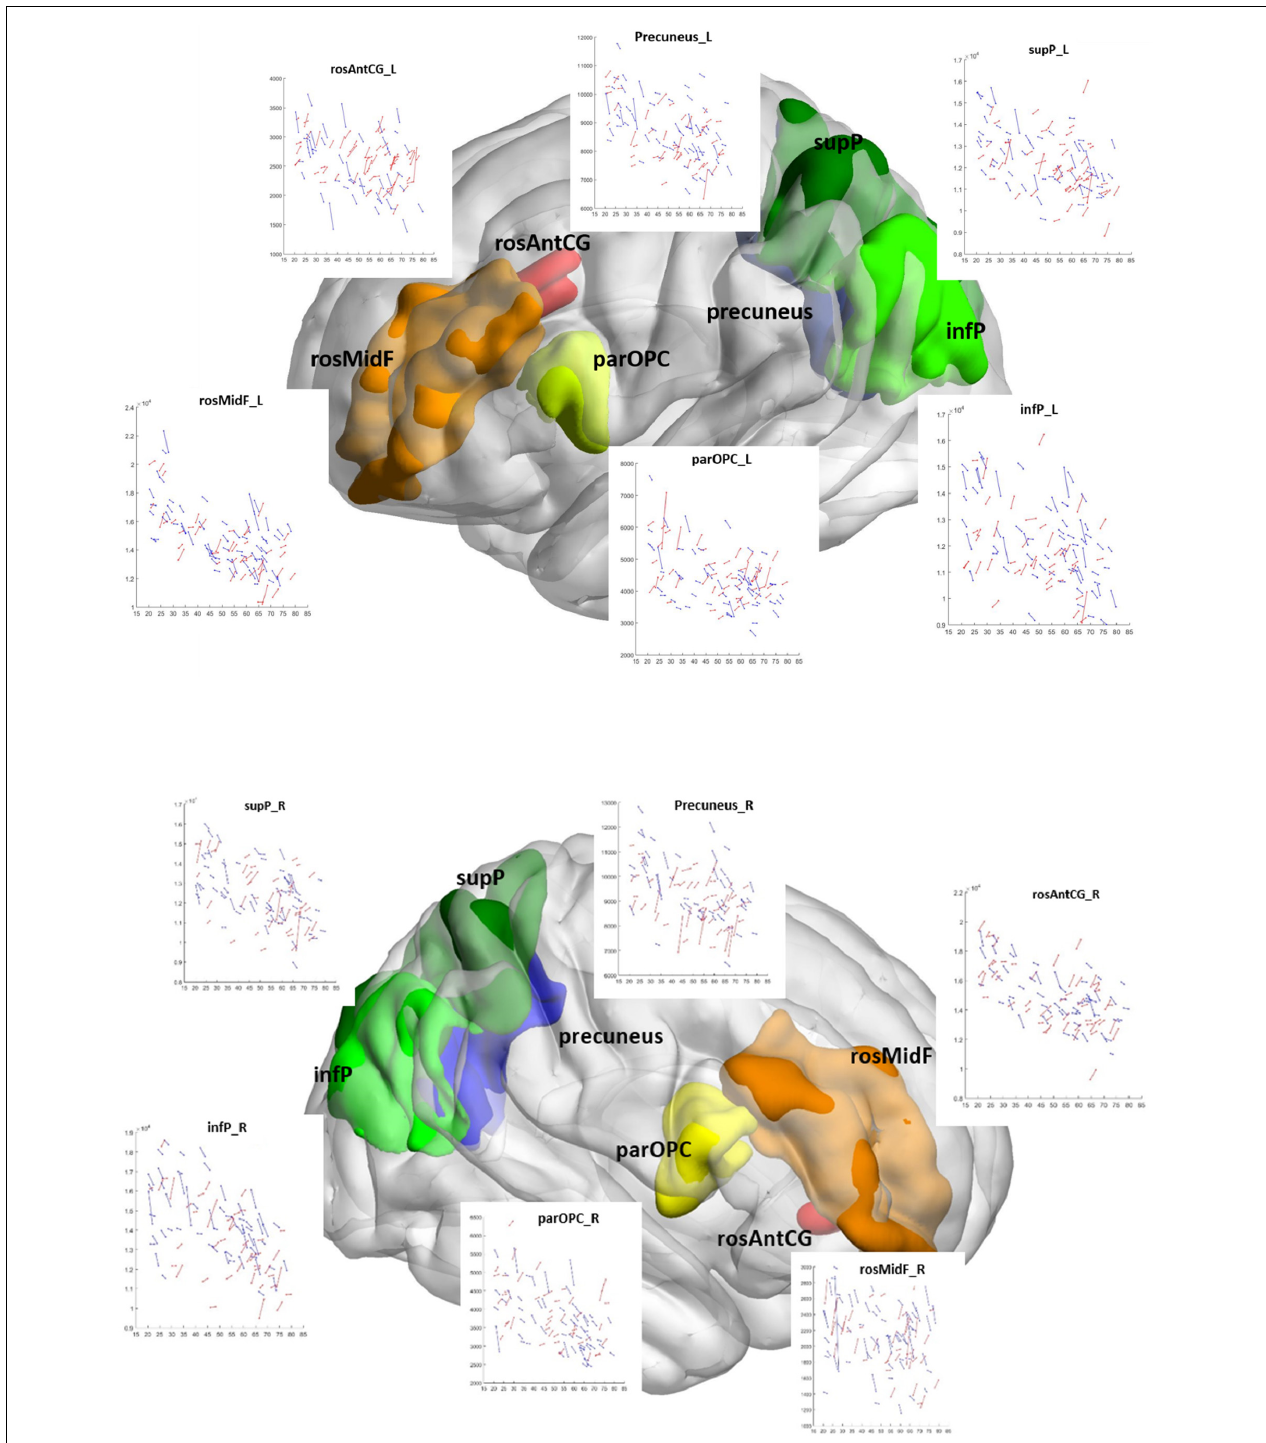
FIGURE 2 | Change in gray matter volume with age at time point 1 in the cognitive control network. Longitudinal gray matter volume trajectories in all 12 ROIs of the cognitive control network are shown as scatter plots of gray matter volume (all y -axis) and age (all x -axis). Each scan is represented by a dot, and repeat scans are connected by lines. Coordinates of the CCN ROIs are plotted within a 3D brain: DLPFC: blue; dACC: yellow-red; DPC: green. L, left; R, right hemisphere; dACC, dorsal anterior cingulate cortex; rosAntCG, rostral anterior cingulate gyrus; DLPFC, dorsolateral prefrontal cortex; infF-parOPC, pars opercularis of the inferior frontal gyrus; rosMidF, rostral middle frontal gyrus; DPC, dorsal parietal cortex; infP, inferior parietal cortex (infP); supP, superior parietal cortex.